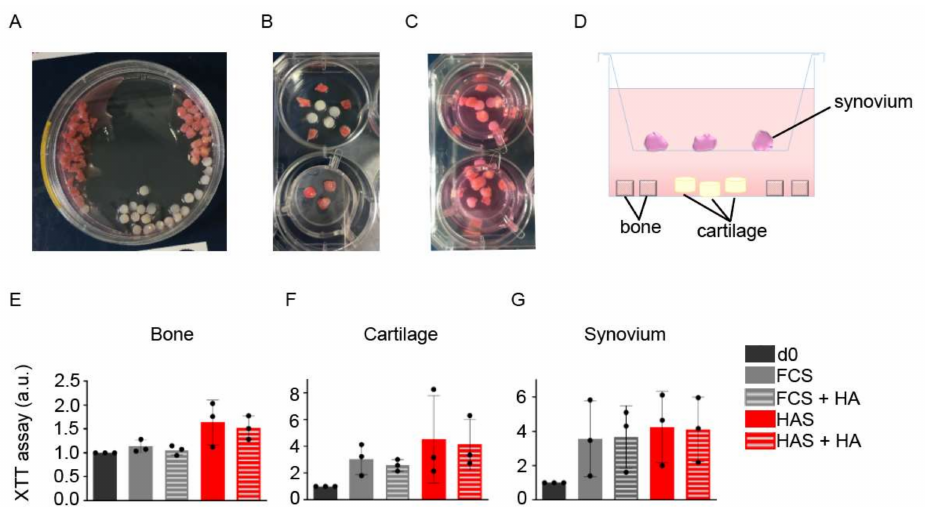
Figure 3. Establishment of an inflammatory ex vivo joint model. ( A ) Bone, cartilage, and synovium fragments from human samples of patients undergoing knee replacement were minced and trans- ferred to cultured wells. ( B , C ) In each well, five fragments of bone, four of cartilage and two or three of synovium were placed as shown in the images and ( D ) in the side view scheme. XTT viability assay after a total of 7 days of culture was performed for ( E ) bone, ( F ) cartilage and ( G ) synovium. Bars represents arithmetic mean values ± SD (n = 3). Abbreviations: day 0 (d0), serum free (SF), fetal calf serum (FCS), hyperacute serum (HAS), platelet-rich plasma (PRP), hyaluronic acid (HA), arbitrary units